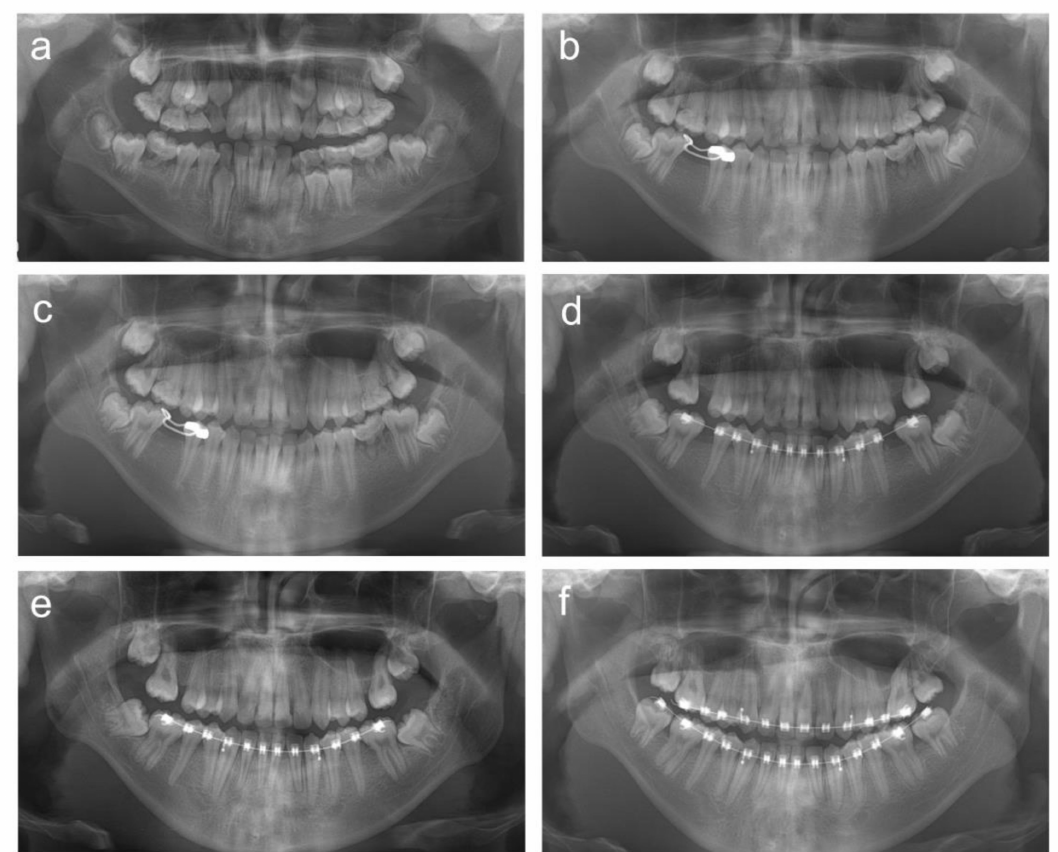
Figure 6. Panoramic radiographs of patient 4. ( a ) Panoramic radiograph at age 11 years 8 months. ( b ) Panoramic radiograph at age 15 years 10 months. ( c ) Panoramic radiograph at age 16 years 5 months. ( d ) Panoramic radiograph at age 17 years 5 months. ( e ) Panoramic radiograph at age 17 years 10 months. ( f ) Panoramic radiograph at age 19 years 1